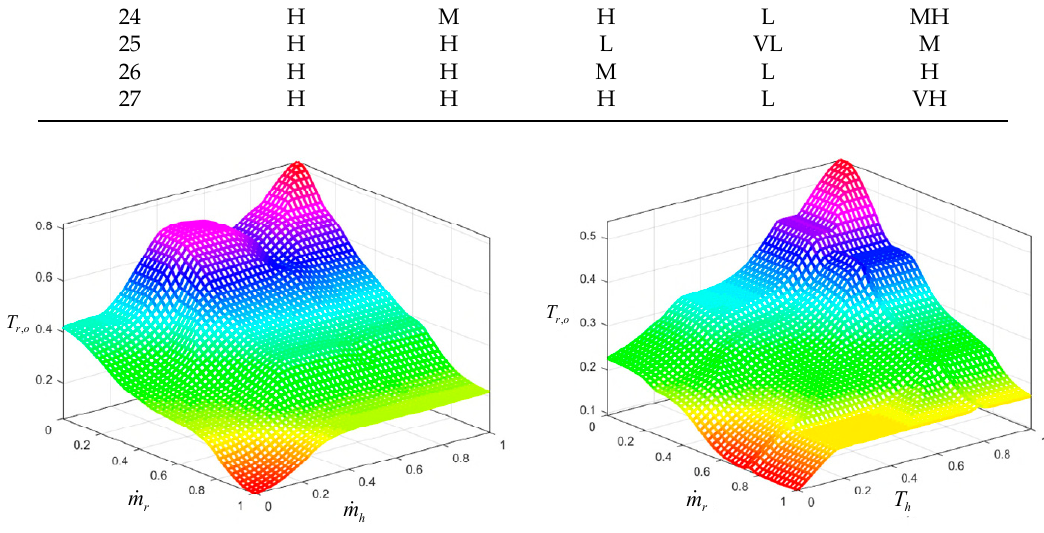
Figure 12. Fuzzy surface of evaporator outlet temperature with respect to . m